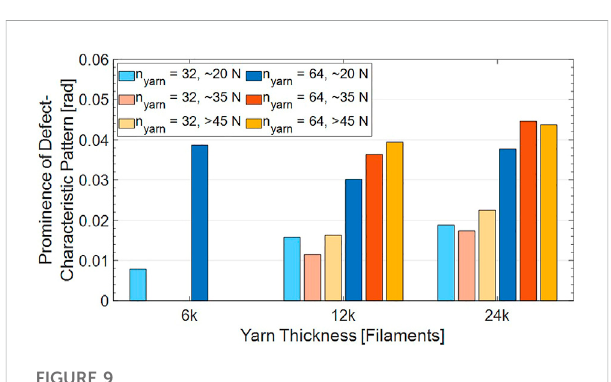
FIGURE 9 Prominence of the defect-characteristic pattern after averaging over the complete duration of each braiding experiment with a simulated